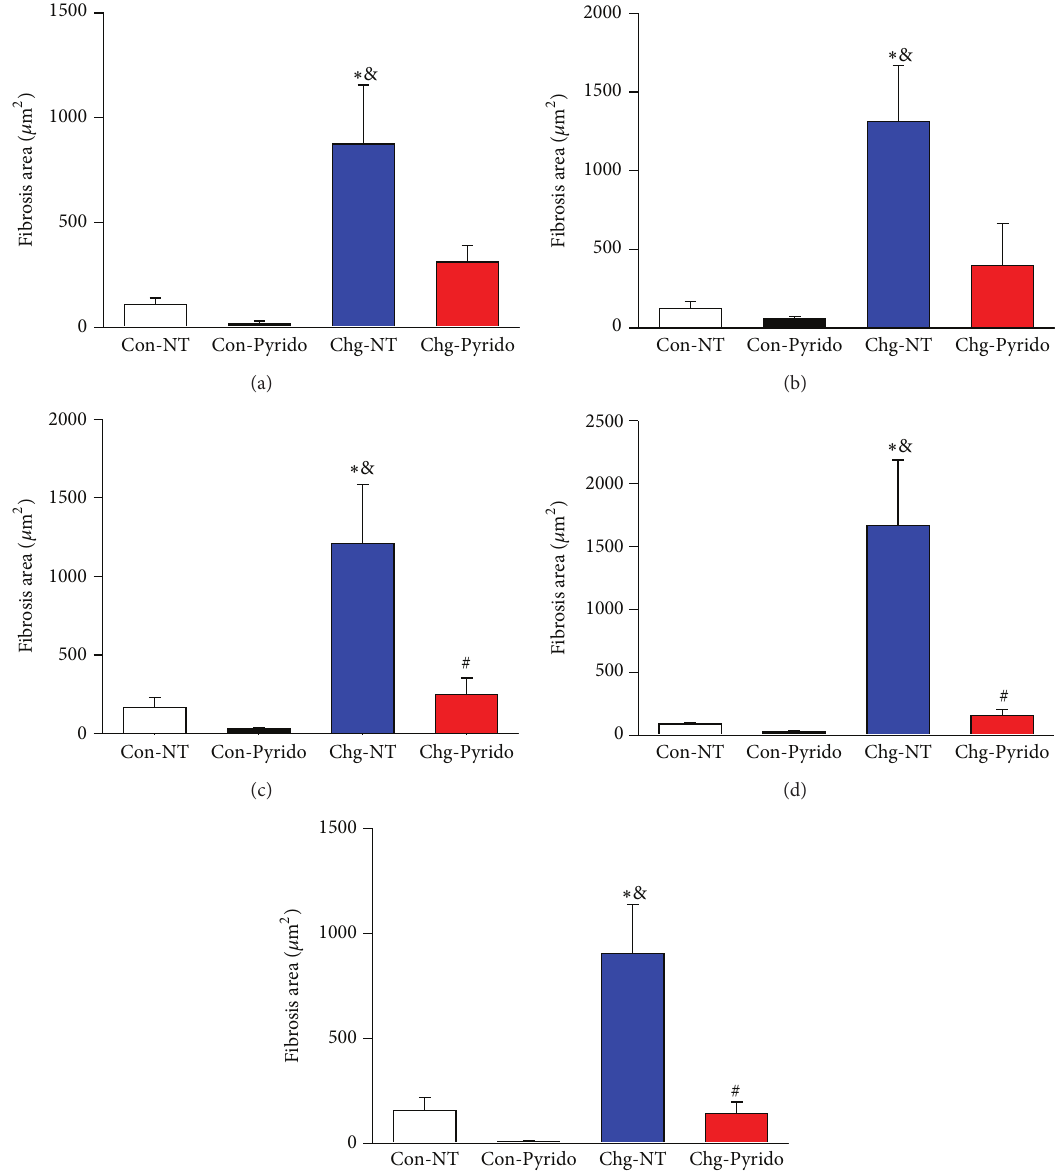
Figure 4: Cardiac fibrosis after treatment with pyridostigmine bromide. Fibrotic areas (in 𝜇 m 2 ) expressed as mean ± S.E.M. for the right (Panel (a)) and left (Panel (b)) atria, the right (Panel (c)) and left (Panel (d)) ventricles, and the atrioventricular septum (Panel (e)), measured after Picrosirius Red staining at the 6th month of observation and after one month of treatment (from the 5th to 6th month of infection) in noninoculated control (Con) or in T. cruzi- inoculated (Chg) C57BL/6j mice treated with pyridostigmine bromide (Pyrido) or vehicle (NT: nontreated animals). ( ∗ 𝑃 < 0.05 versus Con-NT; & 𝑃 < 0.05 versus Chg-Pyrido; and # 𝑃 < 0.05 versus